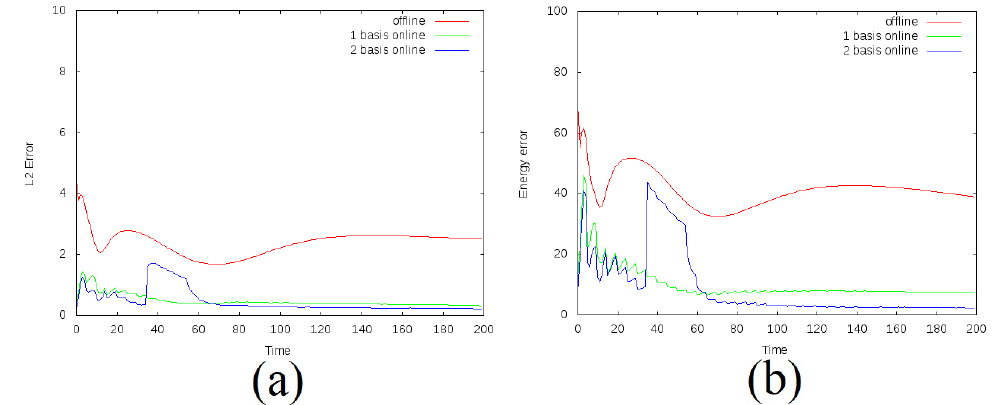
Figure 6. Numerical results for Test 1 . Error comparison between offline approach using 3 offline basis and online approach using 1 and 2 online basis. ( a ): L 2 error. ( b ): energy error.